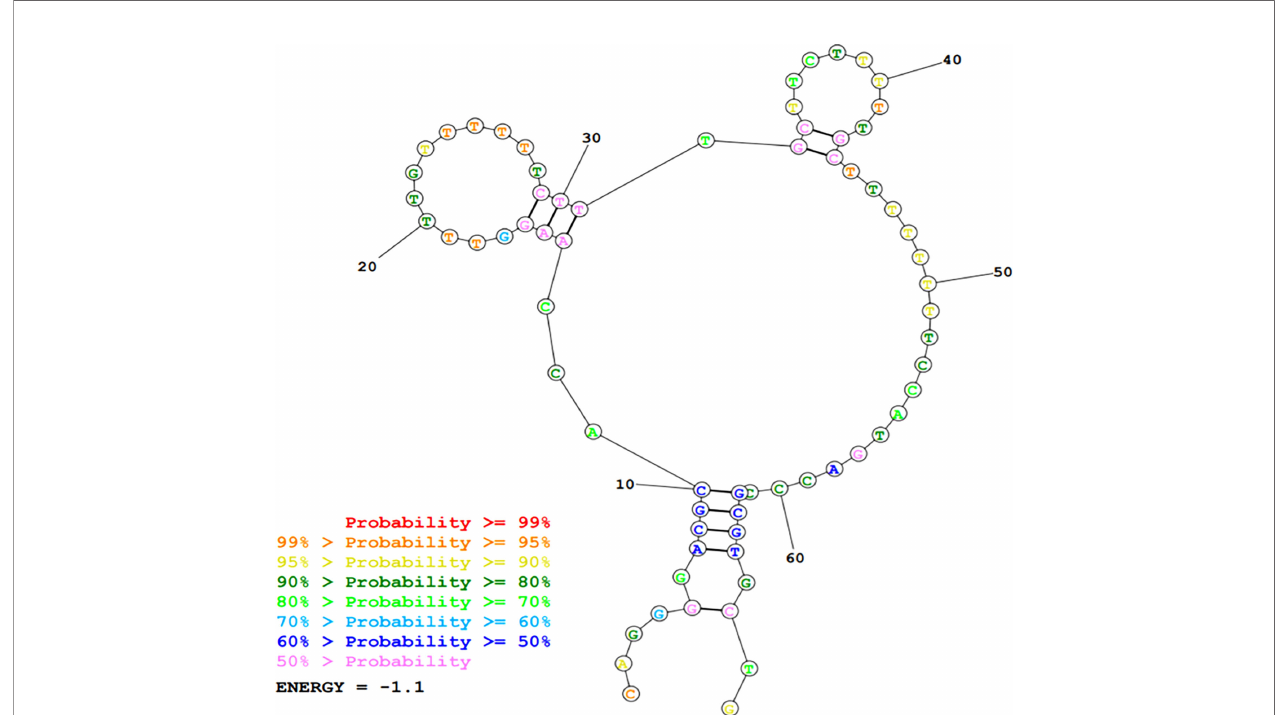
FIGURE 3 | DNA secondary structure prediction of A01 using MaxExpect results structure of RNAstructure software package.